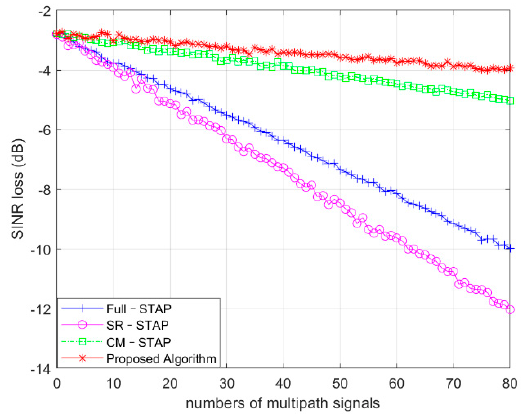
Figure 5. Performance with different numbers of